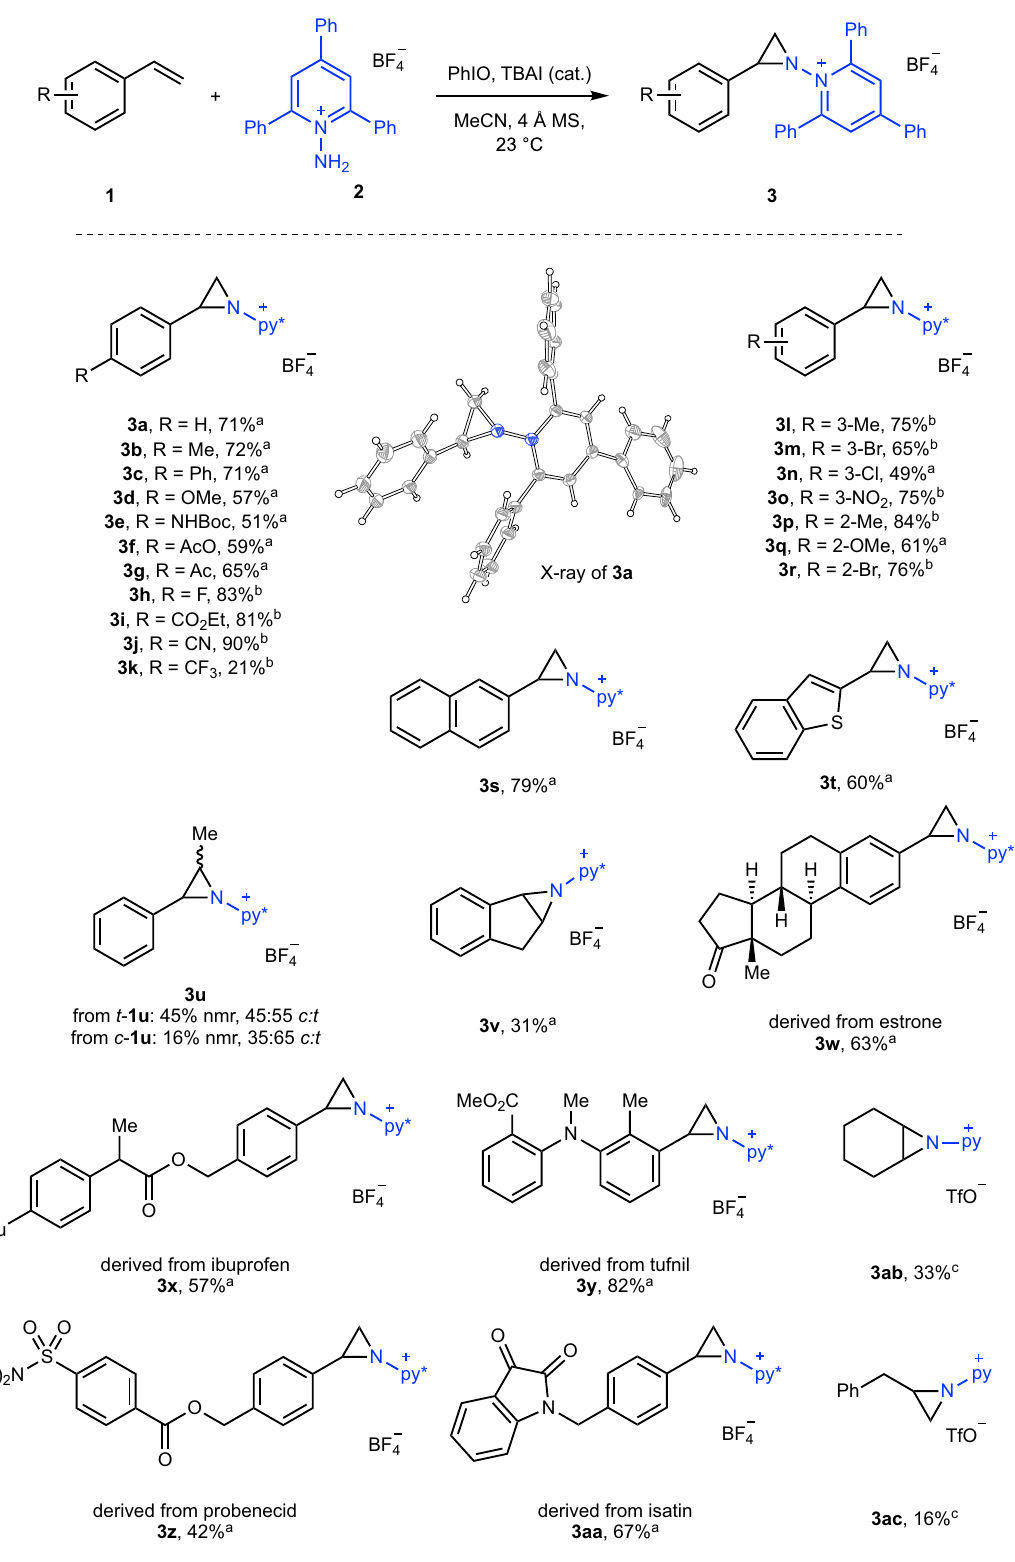
Fig. 2 Iodide-catalyzed ole fi n aziridination. Condition a 1 (1.0 equiv), 2 (1.0 equiv), PhIO (1.0 equiv), TBAI (5 mol%); condition b 1 (1.0 equiv), 2 (1.6 equiv), PhIO (1.6 equiv), TBAI (20 mol%); condition c 1 (1.0 equiv), N -aminopyridinium tri fl ate (1.0 equiv), PhIO (1.0 equiv), TBAI (5 mol%). X-ray structure of 3a presented as displacement ellipsoid plot (50% probability) with BF 4 – counterion removed for clarity. py* = N -2,4,6-triphenylpyridinium, py = N